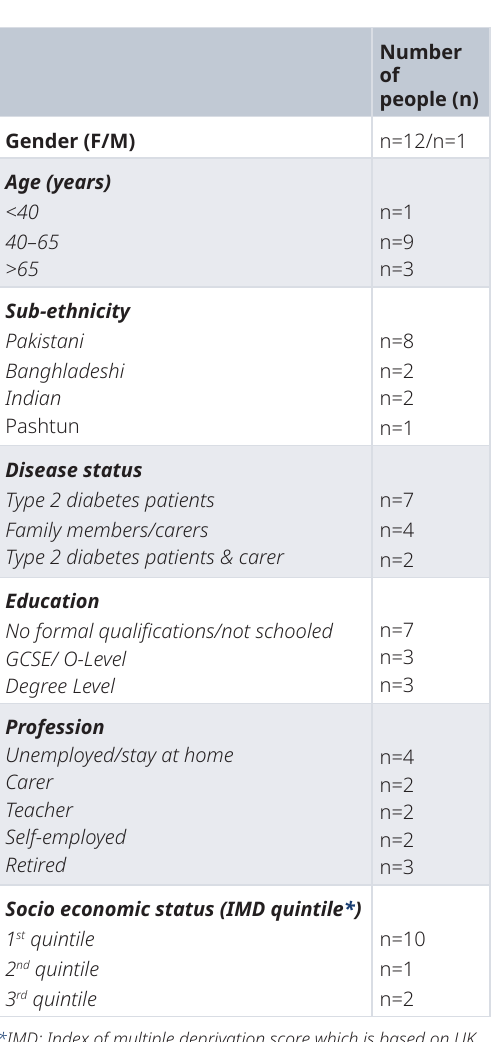
Table 2. Characteristics of people who took part in both